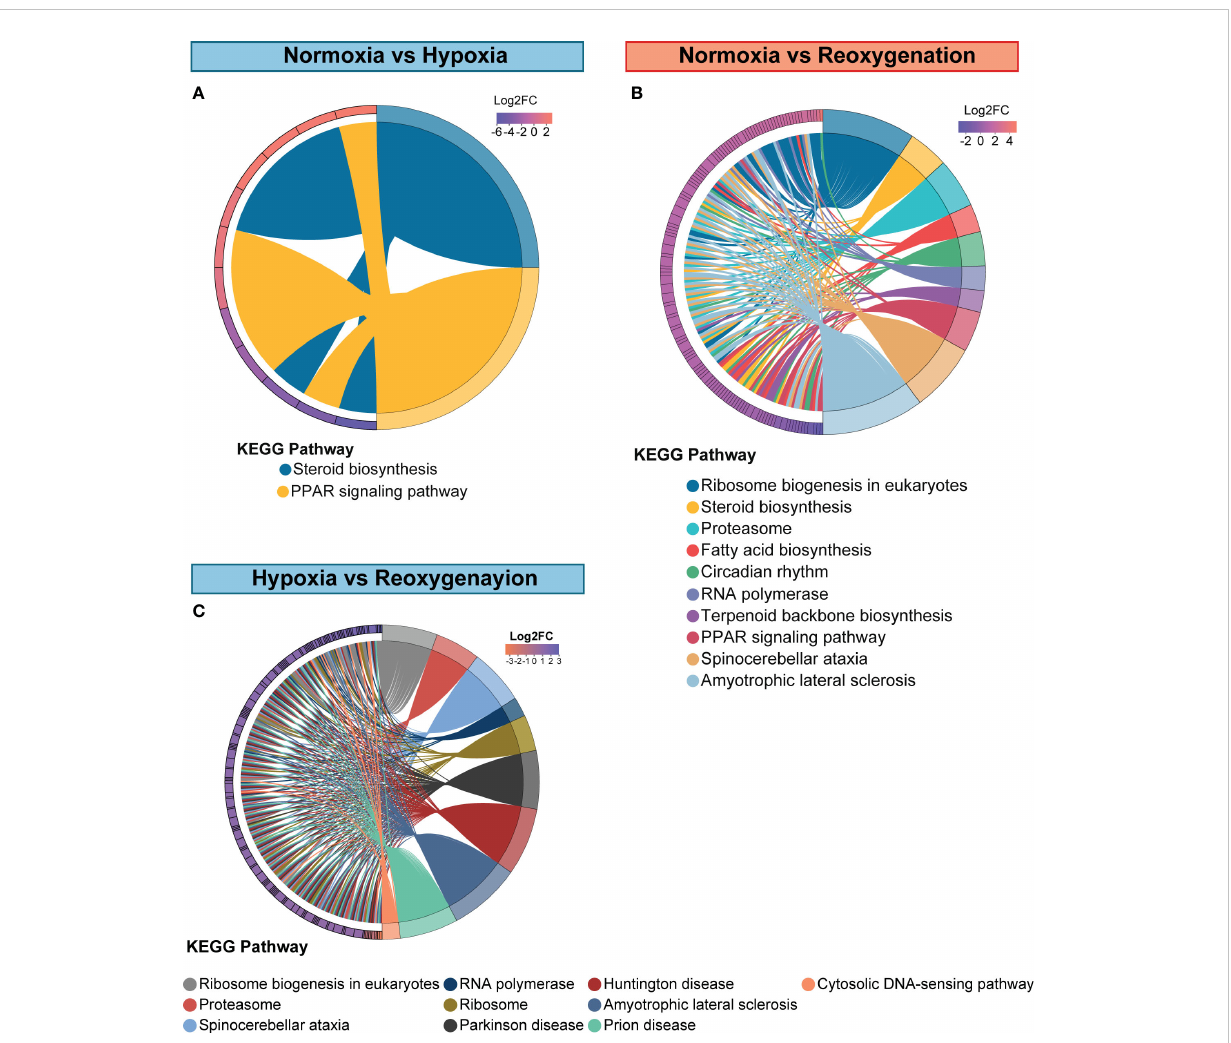
FIGURE 6 Pathway enrichment of differentially expressed genes. (A) KEGG chord plot diagram of DEGs (normoxia vs hypoxia). (B) KEGG chord plot diagram of DEGs (normoxia vs reoxygenation). (C) KEGG chord plot diagram of DEGs (hypoxia vs